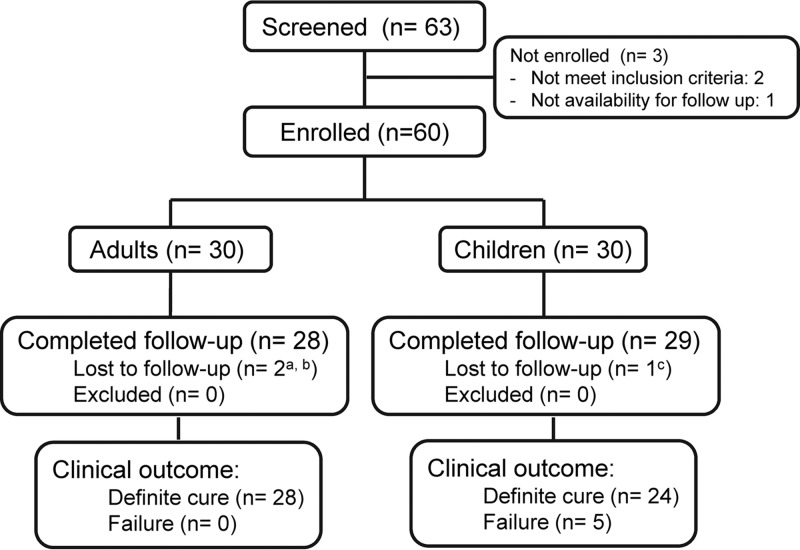
Participant enrollment and follow-up. a, both declared lost at day 90; b, one of two lost patients did not attend the end of treatment visit but attended the day 60 visit; c, declared lost at the day 120 visit.